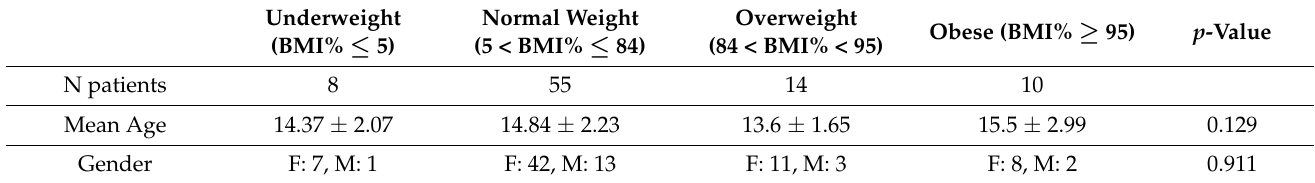
Table 1. Patients’ demographics.